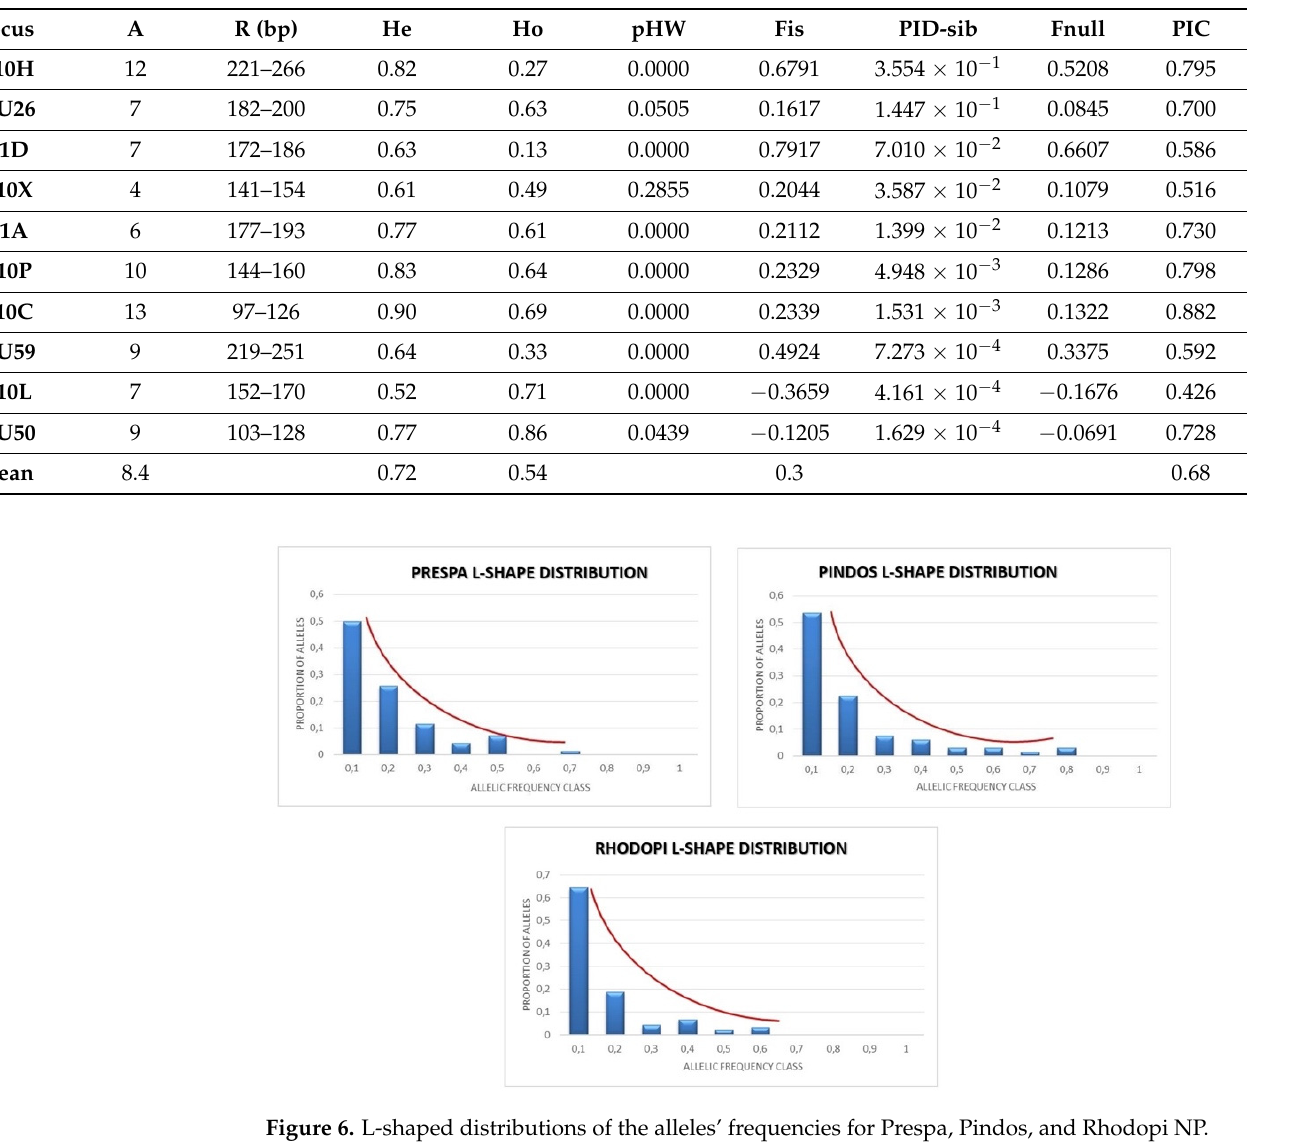
Figure 6. L-shaped distributions of the alleles’ frequencies for Prespa, Pindos, and Rhodopi